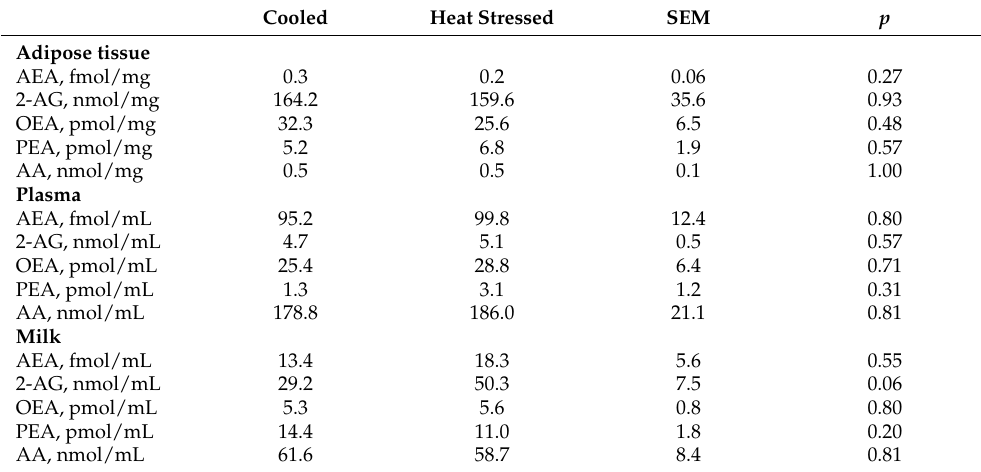
Table 6. Average concentrations of eCBs in AT ( n = 6 per group), plasma ( n = 6 per group) and milk ( n = 10 per group) from cooled vs. heat-stressed late-lactation cows. Cooled Heat Stressed SEM p Adipose tissue AEA,